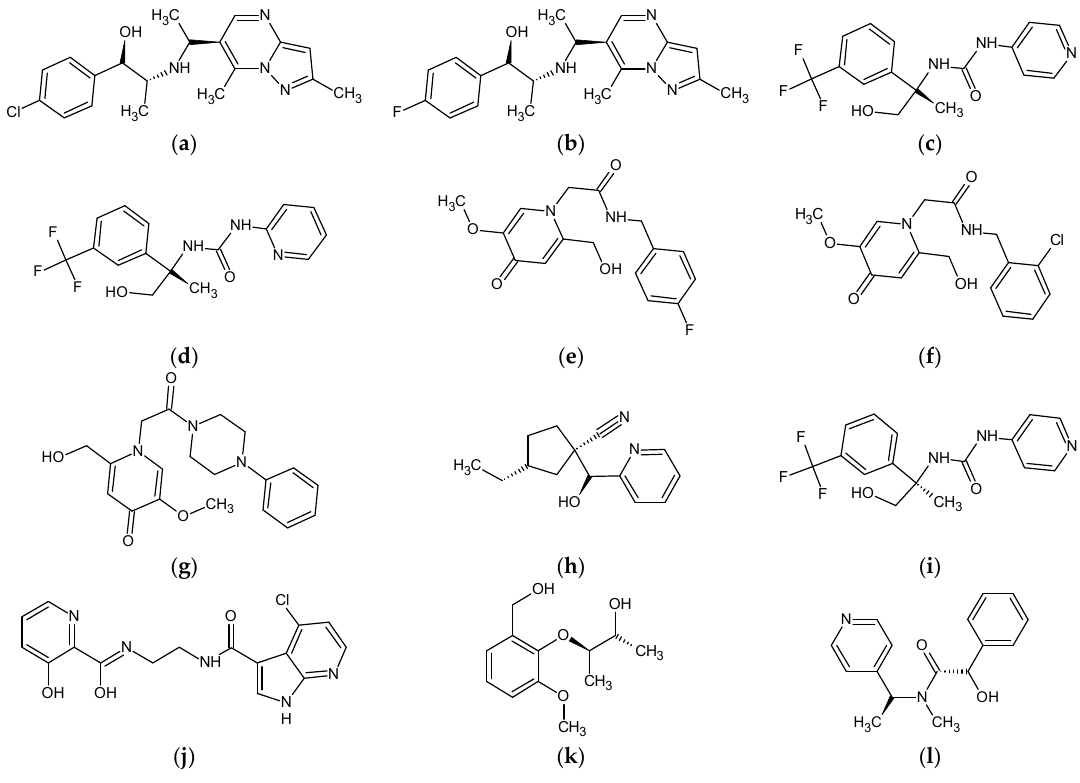
Figure 9. 2D chemical structures of 12 predicted molecules selected with molecular coupling: ( a ) ZINC90174766 ; ( b ) ZINC91725665 ; ( c ) ZINC69349685 ; ( d ) ZINC69431616 ; ( e ) ZINC12230819 ; ( f ) ZINC12230826 ; ( g ) ZINC12230756 ; ( h ) ZINC91881108 ; ( i ) ZINC69349687 ; ( j ) ZINC89571615 ; ( k ) ZINC87131463 and ( l ) ZINC81021663 .